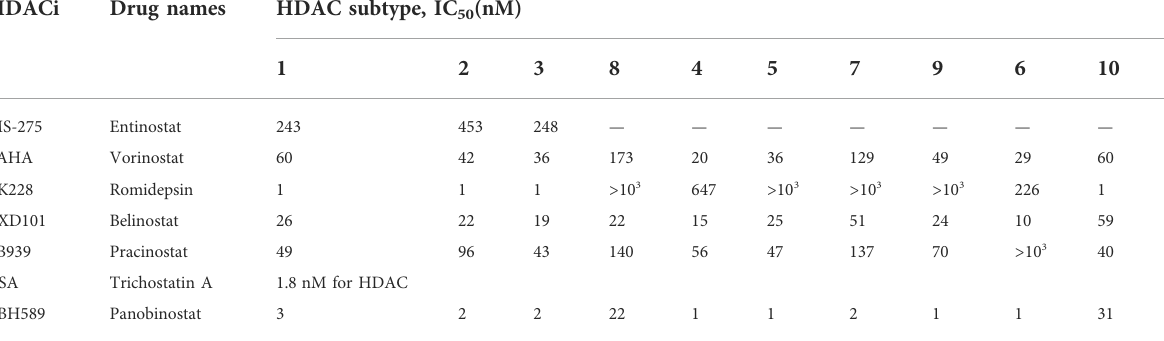
TABLE 3 IC 50 values of HDAC inhibitors (Novotny-Diermayr et al., 2010; Lauffer et al., 2013; Ho et al., 2020; Bondarev et al., 2021).